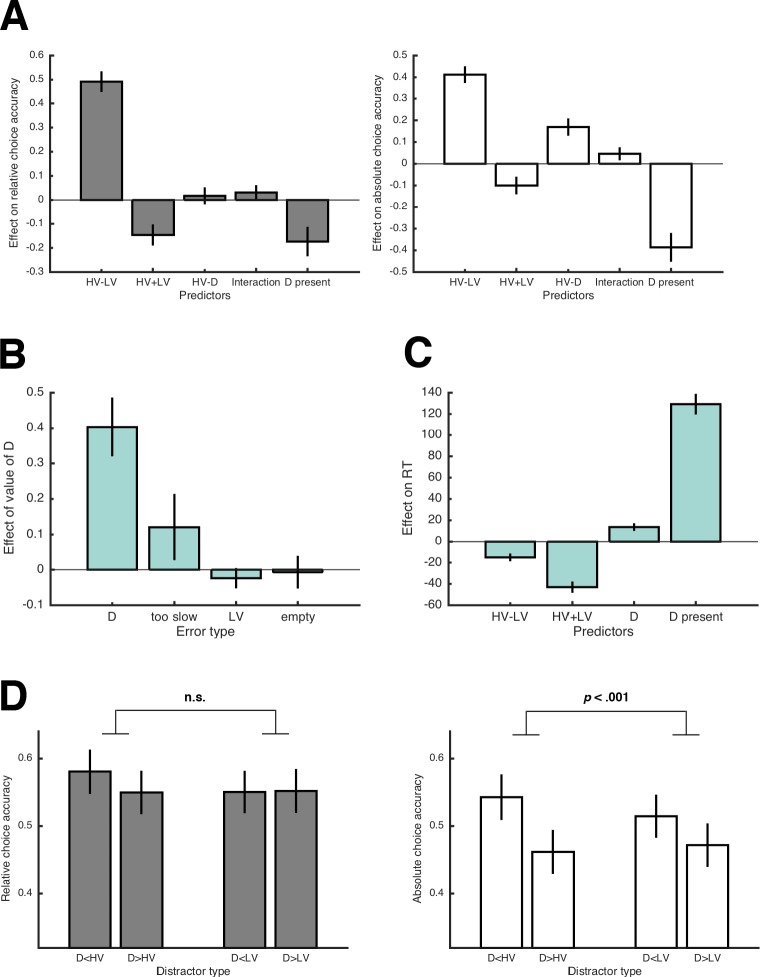
Summary of behavioral results of Experiment 1 to 4.(A) to (D) are analogous to Figure 2 but collapsed over all experiments conducted under high time pressure. Results in (D) only contain data from Experiment 1 to 3, because novel trials were omitted in Experiment 4.